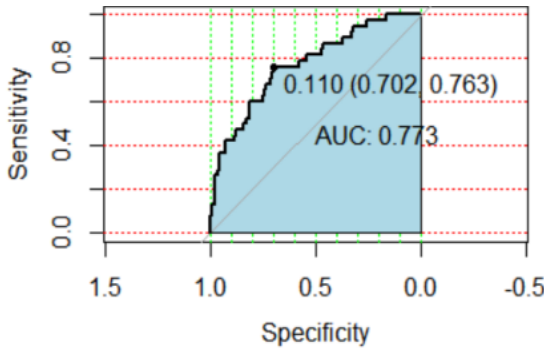
Figure 2. ROC curve of mastitis prediction. Table 8. Risk factors of mastitis.